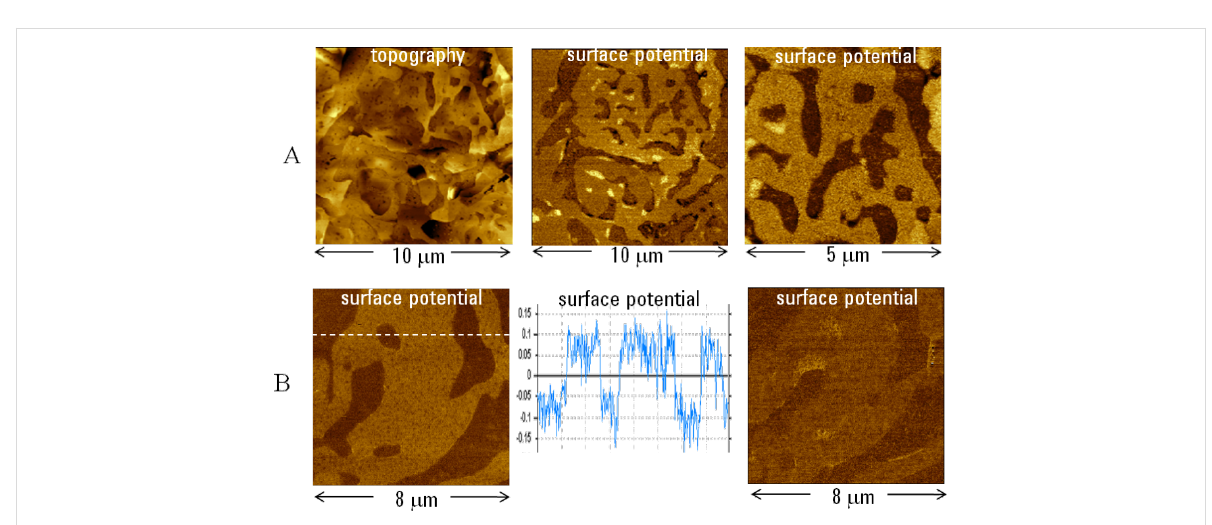
Figure 5: Topography and surface potential images recorded on two Bi/Sn samples. The images in A were obtained on the sample that is character- ized by several levels of the surface potential contrast. The contrast covers the height corrugations in the 0–60 nm range in the topography image and the potential variations in the 0–0.4 V range in the surface potential images. The surface potential images in B were obtained on a freshly-prepared Bi/Sn sample (left) and the same sample after the overnight storage in air (right). The graph between the images displays the potential profile taken in the left image along the direction marked with a dashed white